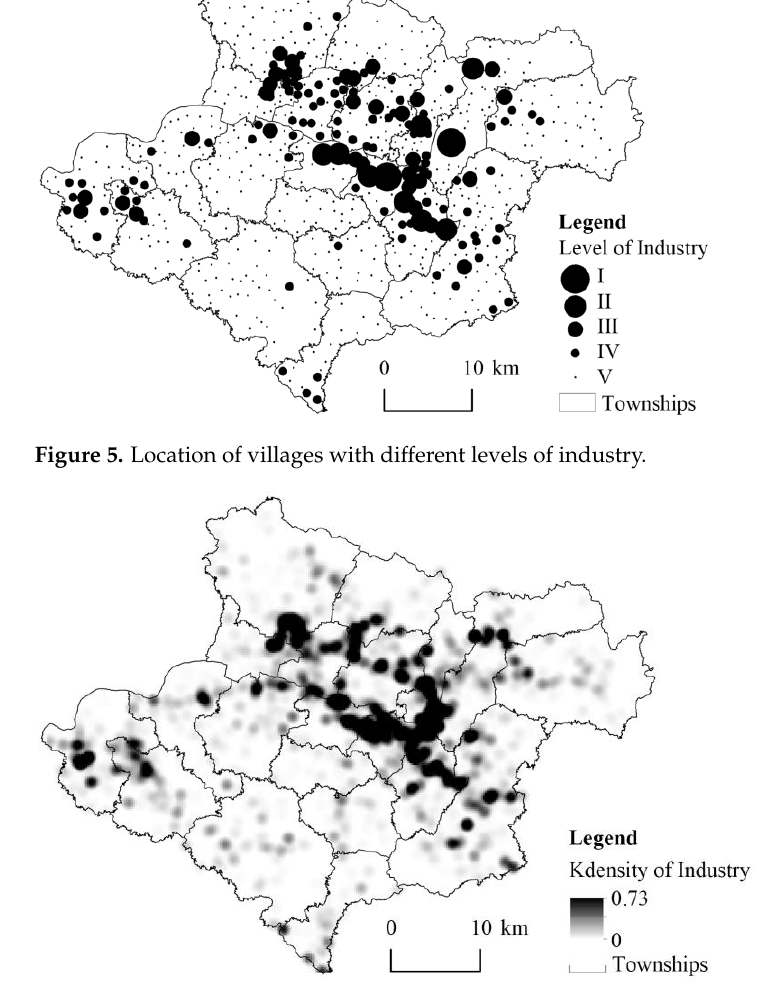
Figure 5. Location of villages with different levels of industry.